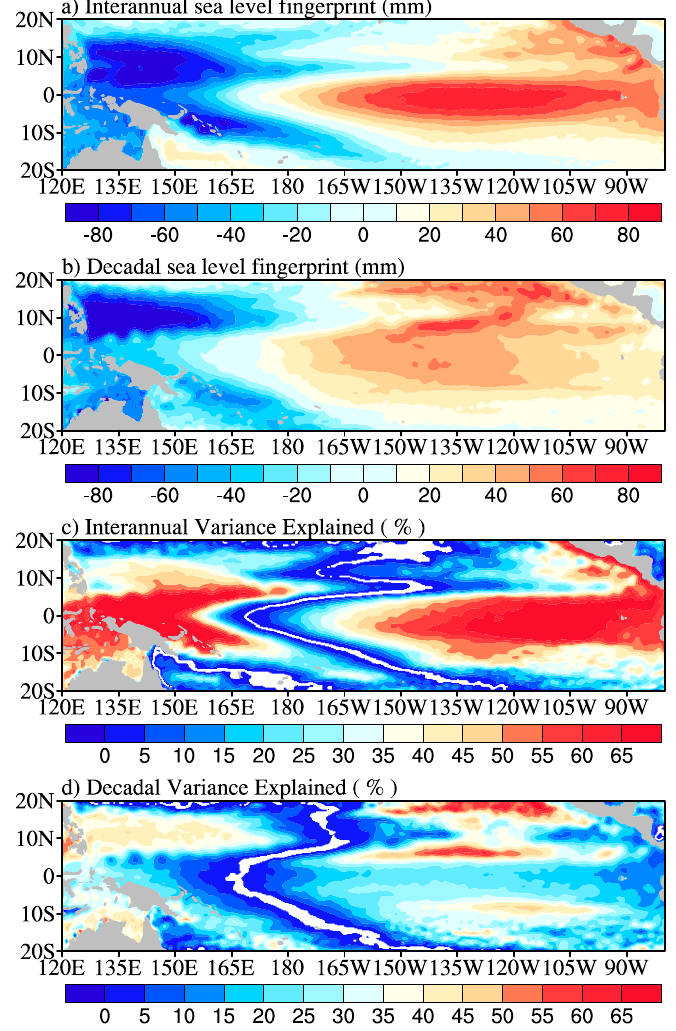
Figure 12. ( a ) Interannual sea level fingerprint (mm) ( b ) decadal sea level fingerprint (mm), ( c ) the explained variances of the interannual sea level associated with the ENSO, ( d ) the explained variances of the decadal sea level related to the PDO.